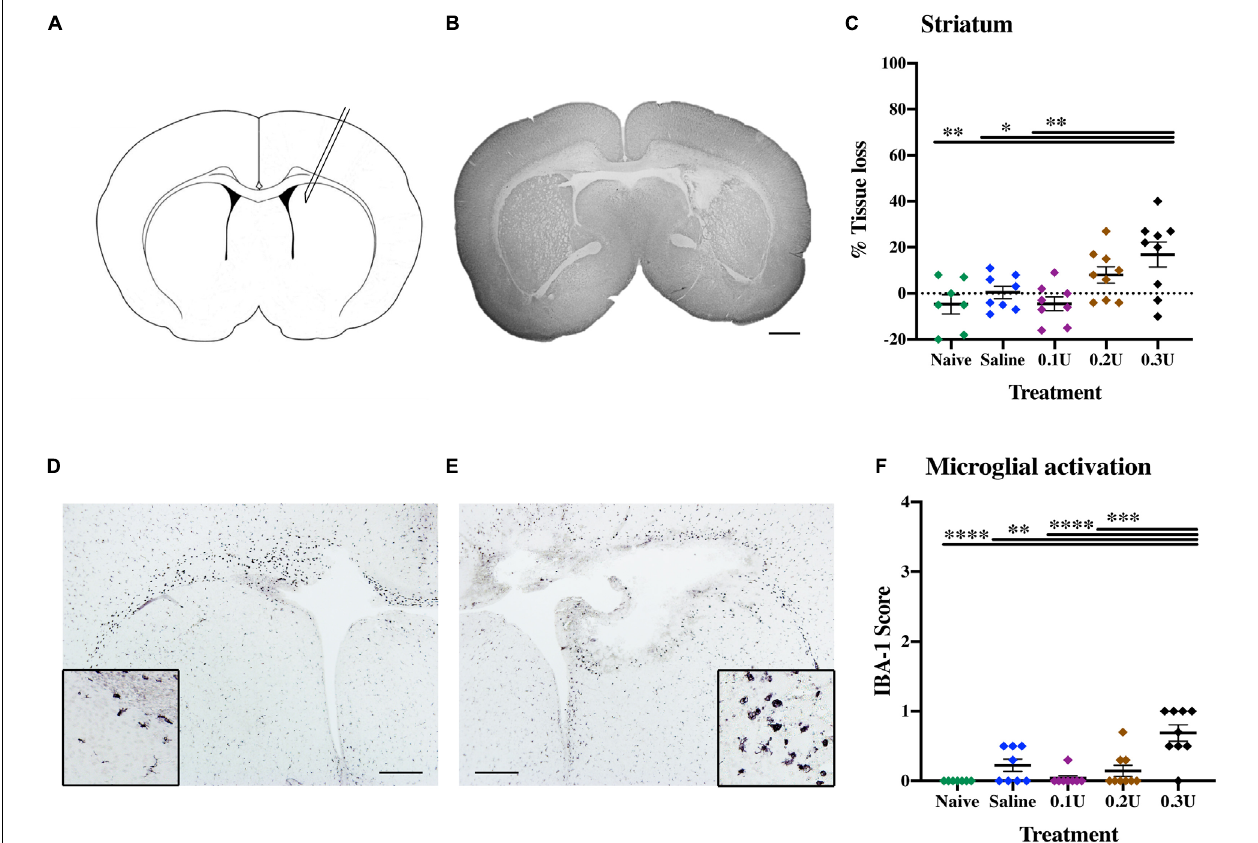
FIGURE 1 | Optimal collagenase dose to induce GMH. (A) Diagram of ICV injection site, with needle insertion located at 4 mm lateral of the midline and 1 mm rostral of bregma, with an insertion depth of 3.5 mm. (B) Representative MAP-2-stained whole brain micrograph of 0.3 U collagenase-mediated injury 24 h after injection. (C) Effect of different treatments—naïve ( n = 8), saline ( n = 8), 0.1 U ( n = 8), 0.2 U ( n = 9), and 0.3 U ( n = 9) collagenase—on ipsilateral striatum tissue loss 24 h after injection. (D) Contralateral and (E) ipsilateral micrographs with magnification inserts ( × 20) showing IBA-1 microglia staining 24 h after injection. (F) Assessment of microglia activation (IBA-1) in the ipsilateral striatum 24 h after different collagenase dose administrations. Data represented as individual animals ± SEM and analyzed using one-way ANOVA followed by Tukey’s multiple comparison test. ∗ P < 0.05, ∗∗ P < 0.01, ∗∗∗ P < 0.001, and ∗∗∗∗ P < 0.0001. Scale bar = 1 mm in (B) ; 0.5 mm in (D,E)